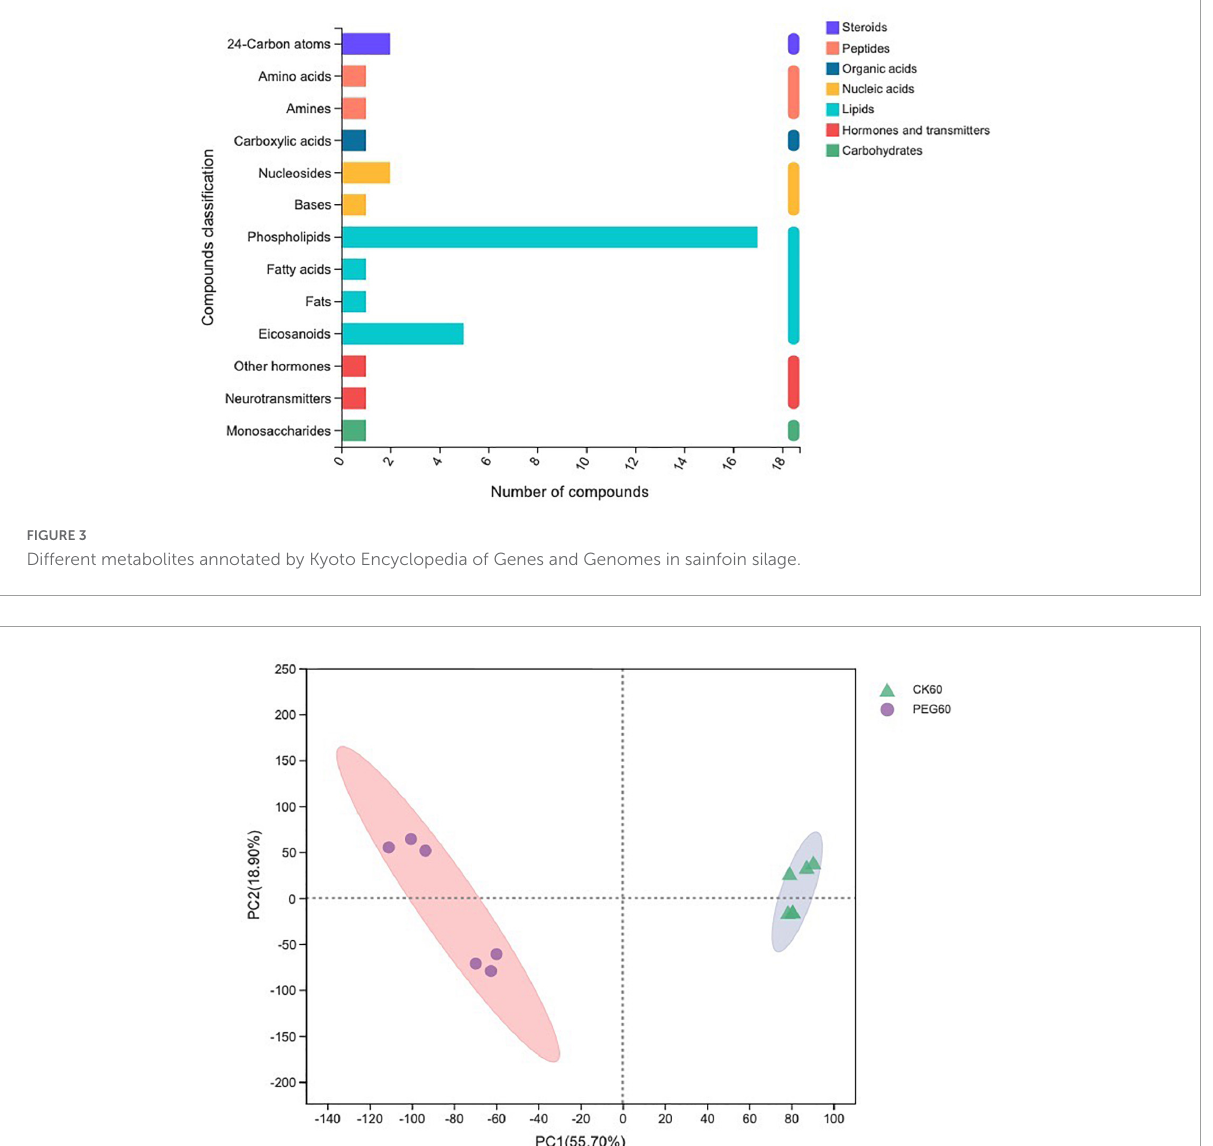
− 0.8286, − 0.8286, − 0.8286, − 0.8286, − 0.9429, − 1, −